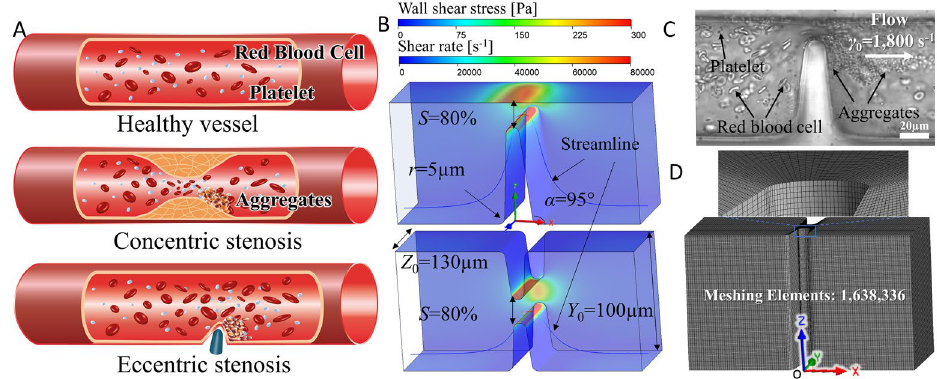
Figure 1. Pathological and physiological blood vessel stenoses and the mimicking microfluidic models. ( A ) Blood flow in a healthy vessel without stenosis ( top ), in a vessel with concentric stenosis due to atherosclerotic plaque ( middle ) and a vessel with eccentric stenosis due to medical device insertion ( bottom ). ( B ) CFD contour maps in the eccentric ( top ) and concentric ( bottom ) stenosis microfluidic channels. Note that the channel walls were colored to display the WSS distribution; the representative streamline of a platelet trajectory was colored to display the shear rate γ distribution. ( C ) Differential interference contrast microscopy image of biomechanical platelet aggregation in an eccentric stenosis microfluidic channel after whole blood perfusion at γ 0 = 1,800 s −1 , mimicking the physiological shear rate in arteries and arterioles 7 . To visualize platelet aggregates in better clarity, the microchannel was washed with Tyrode’s buffer after whole blood perfusion. Note that platelets aggregate at the downstream face of the stenosis. Scale bar = 20 µm. (D) ANSYS finite volume meshing scheme for the concentric stenosis model as in panel C. The entire microfluidic channel was meshed into 1,638,336 hexahedral elements for CFD analysis. The coordinate origin is located at the center of the front bottom edge. Note that for illustration purpose, a coarse mesh is shown in the figure.